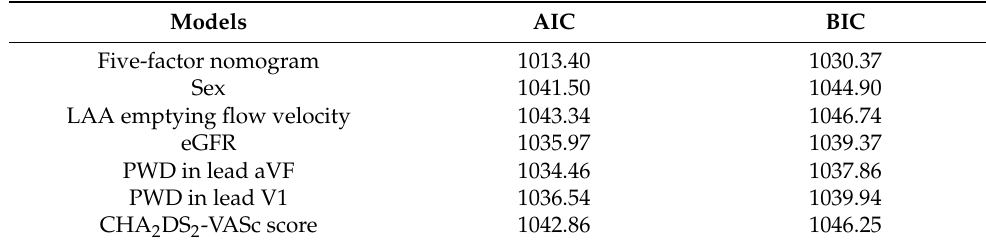
Table 4. The AIC, BIC of predictors, the five-factor nomogram, and the CHA 2 DS 2 -VASc score.